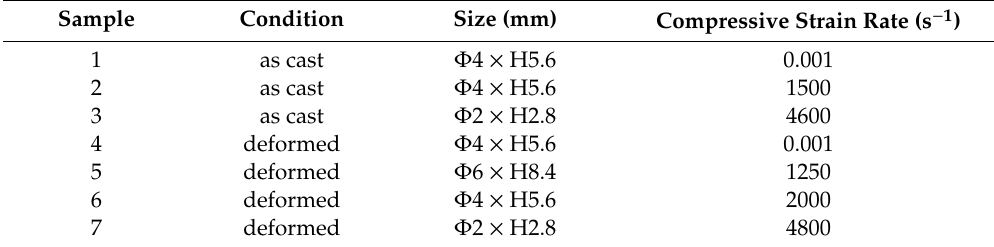
Table 2. Sizes and the compressive strain rates of the samples.